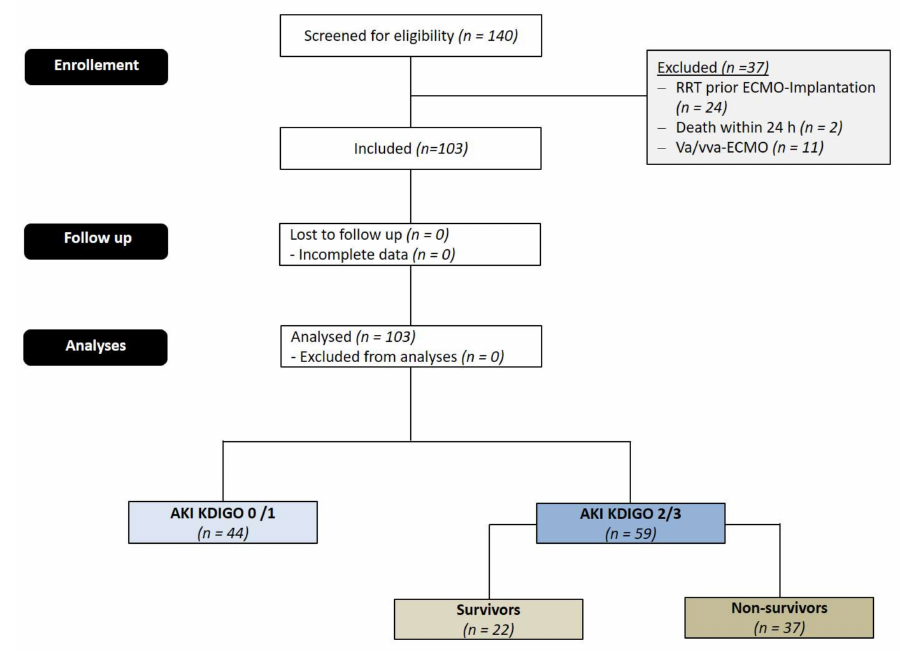
Figure 1. CONSORT Flow